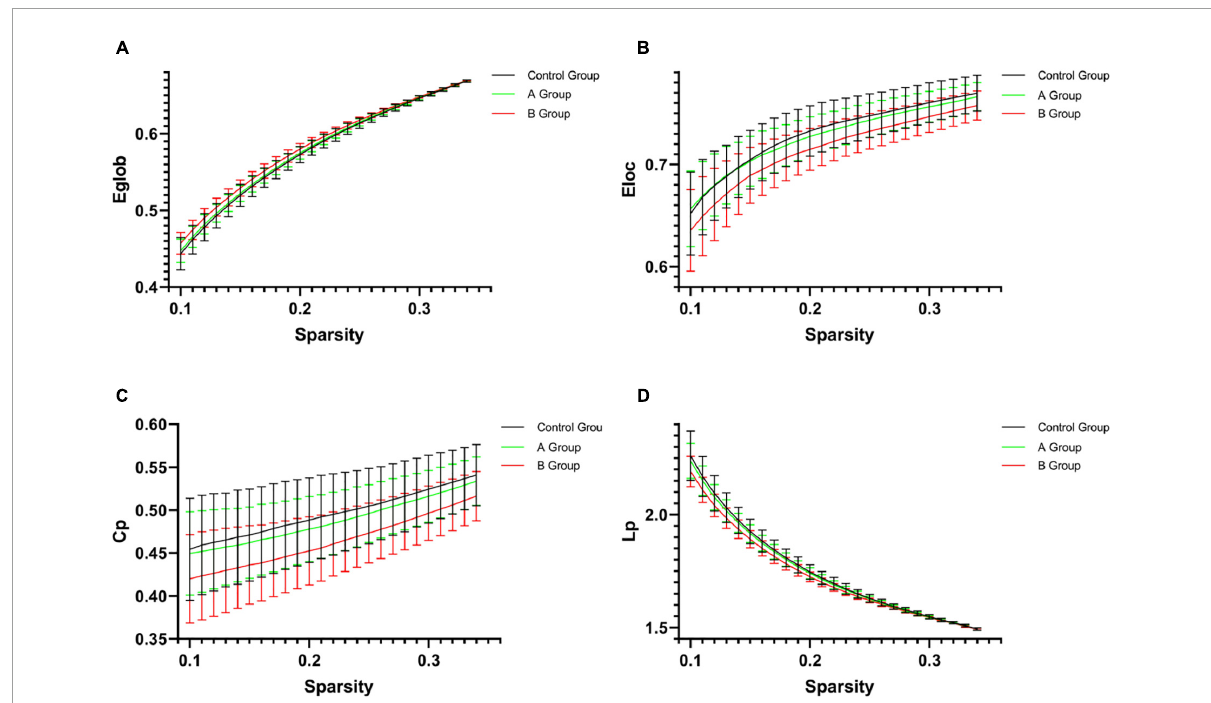
FIGURE3 The network parameters [ (A) Eglob; (B) Eloc; (C) Cp; and (D) Lp] of control group, A group and B group within a given threshold range. Error bars represent standard errors. As compared with control group, B group exhibited increased E glob ( p = 0.004) but decreased E loc ( p = 0.001), C p ( p = 0.001), and L p ( p = 0.003). When compared with A group, B group presented increased E glob ( p = 0.001) but decreased E loc ( p < 0.001), C p ( p < 0.001), and L p ( p = 0.001). E glob , global efficiency; E loc , local efficiency; Cp, clustering coefficient; Lp, characteristic path